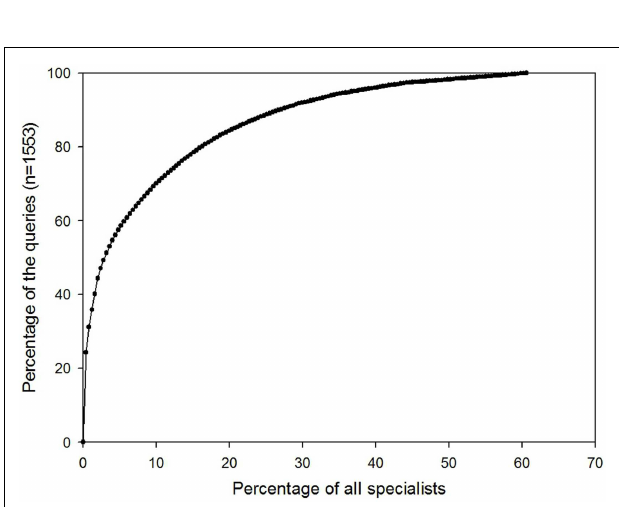
FIGURE 5 | Percentage of all referrers who had submitted a case .